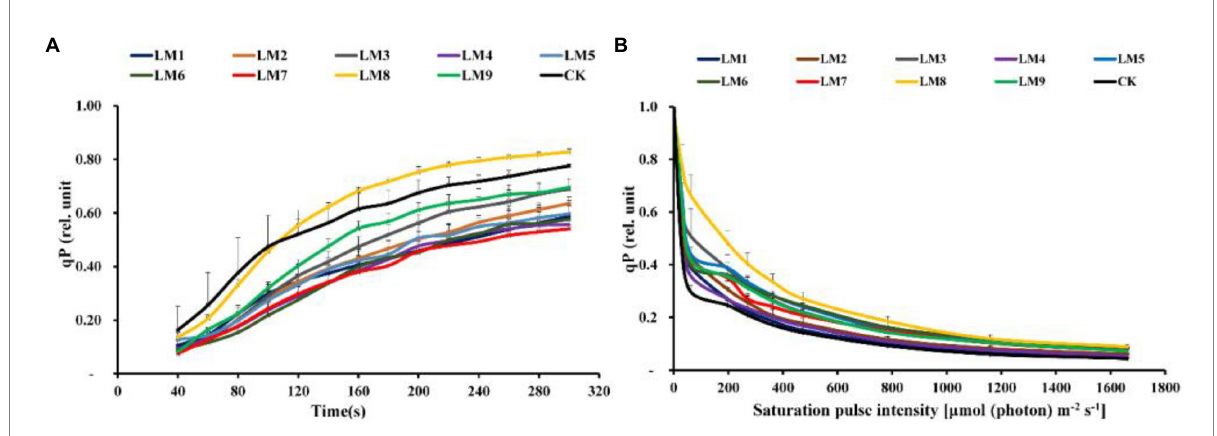
FIGURE 8 Effects of LED light modes on the induction kinetics of chlorophyll a fluorescence in dark-acclimated (A) and light-acclimated (B) of photochemical quenching coefficient (qP) in strawberry leaves. The points represent the means ± SE of 16 (4 × 4) repeats, followed by the identical letters, indicating that the Duncan test found no significant differences ( p ≤ 0.05).